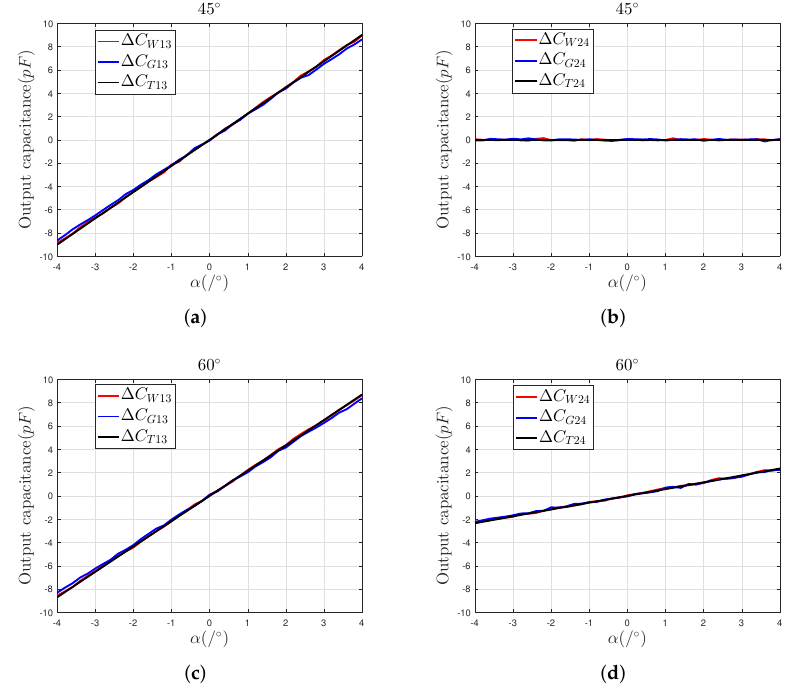
Figure 3. Simulation results: ( a ) the simulation output ∆ C 13 of the 3D finite element model in the direction of 45 ◦ , ( b ) the simulation output ∆ C 24 of the 3D finite element model in the direction of 45 ◦ , ( c ) the simulation output ∆ C 13 of the 3D finite element model in the direction of 60 ◦ , ( d ) the simulation output ∆ C 13 of the 3D finite element model in the direction of 60 ◦ .